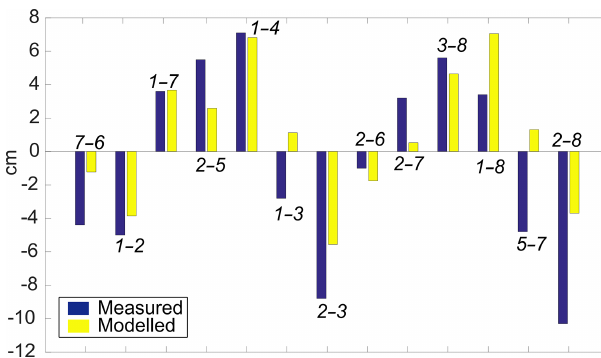
Figure 5. Comparison between observed (blue bars) and modeled (yellow bars) slope distance. Numbers as in Fig. 2. It can be noticed that the worst fit occurs for baselines not crossing any